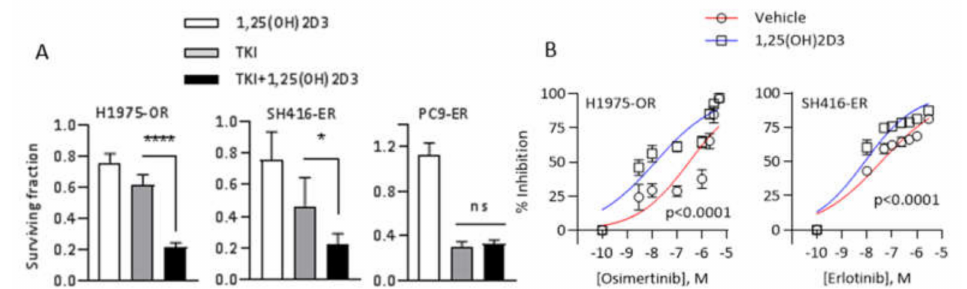
Figure5. 1,25(OH)2D3restoressensitivitytoEGFRTKIsinEMT-associatedmodelsofacquiredresistance to EGFR targeted therapies. ( A ) H1975, SH416, and PC9 cells and the corresponding TKI-resistant sublines were treated with vehicle control, 1 µ M erlotinib (SH416 / SH416ER and PC9 / PC9–ER) or 0.5 µ M osimertinib (H1975 / H1975–OR), 100 nM 1,25(OH)2D3, or combination of the above agents every 72